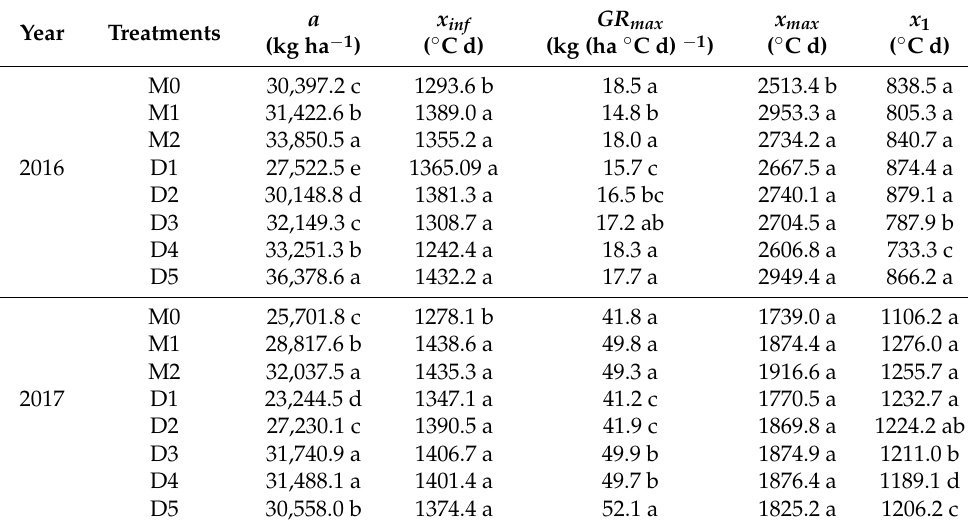
Table 7. Effects of different treatments on dynamic characteristic parameters of dry matter accumula- tion. Different letters are significantly different at the p < 0.05 probability level.